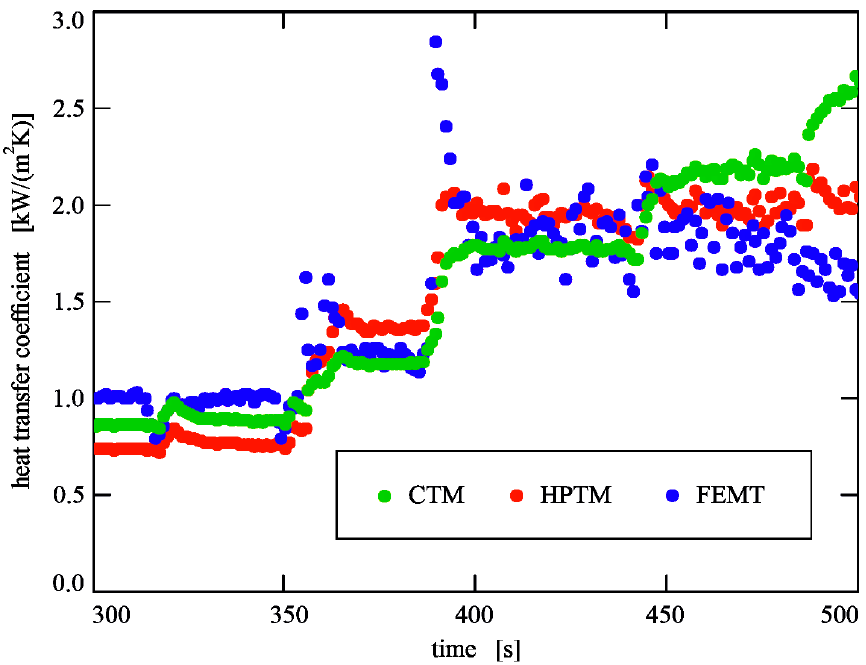
Figure 13. Heat transfer coefficient versus time, the distance from the mini-channel inlet x = 0.0306 m; other experimental parameters are listed in Table 1.